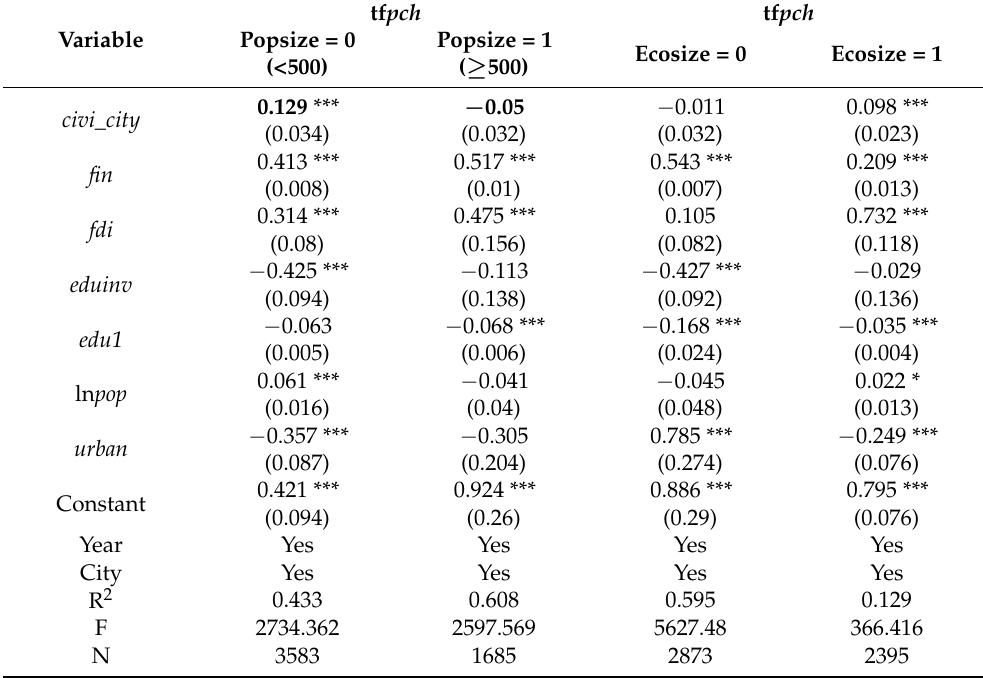
Table 7. Heterogeneity